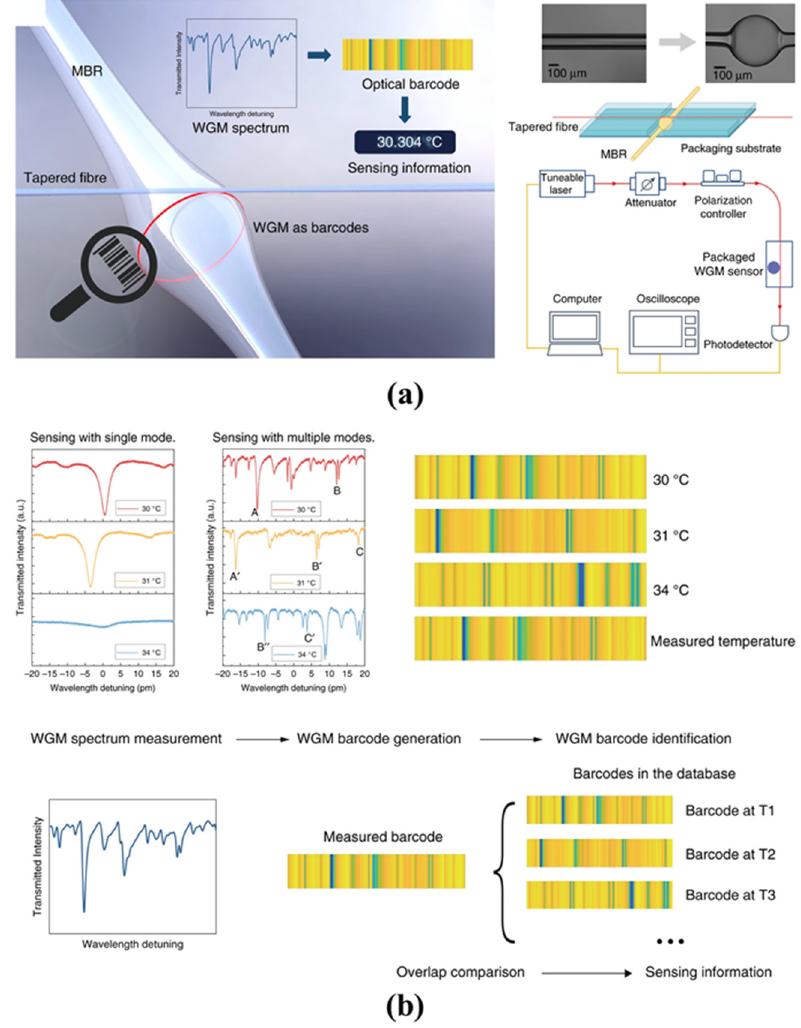
Figure 8. Temperature sensing with WGM microbubble resonators based on optical WGM barcode technology (reprinted with permission from [118], © CC BY license): ( a ) the sensing system of optical WGM barcode technology; ( b ) sensing principle of the optical WGM barcode technology.